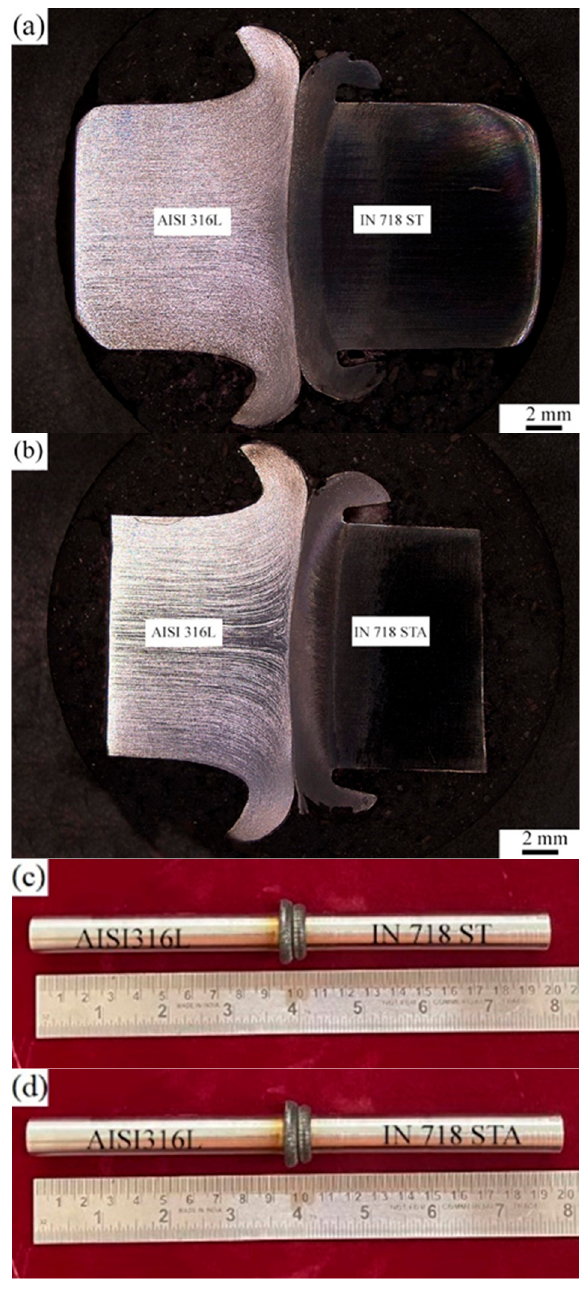
Figure 4. Macrograph and visual view of dissimilar friction welds AISI 316L/IN 718 ST ( a , c ) and AISI 316L/IN 718 STA ( b , d ).